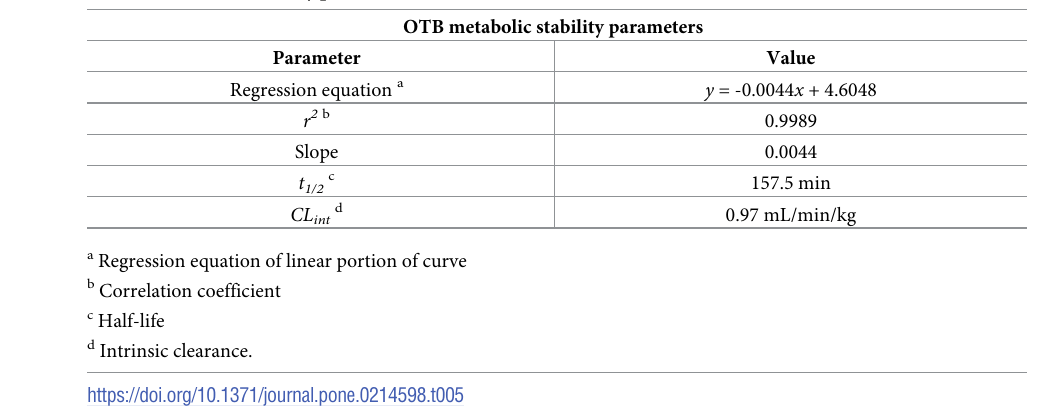
Table 5. Metabolic stability parameters for DMB incubation with RLMs.